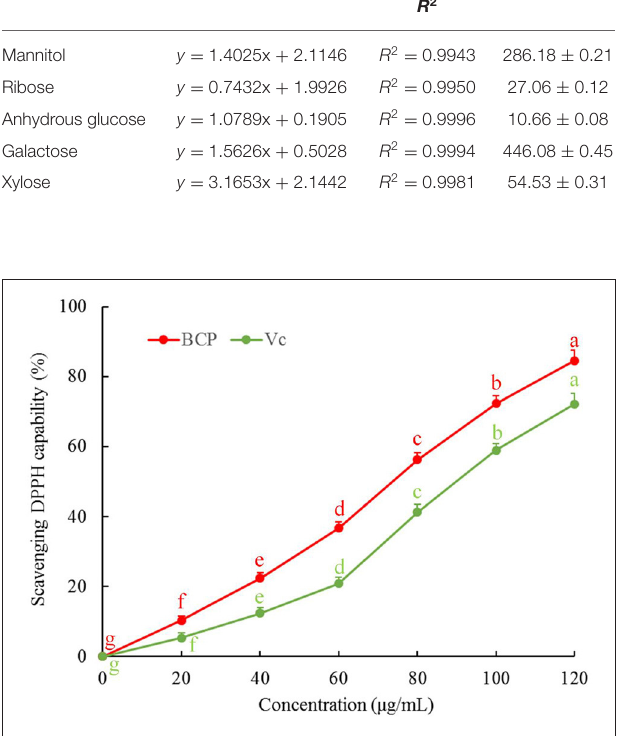
FIGURE 2 | DPPH free radical scavenging capacity of blood cora polysaccharides. a − g Mean values with different letters over the bar are significantly different ( P < 0.05) according to Tukey’s honestly significant difference.